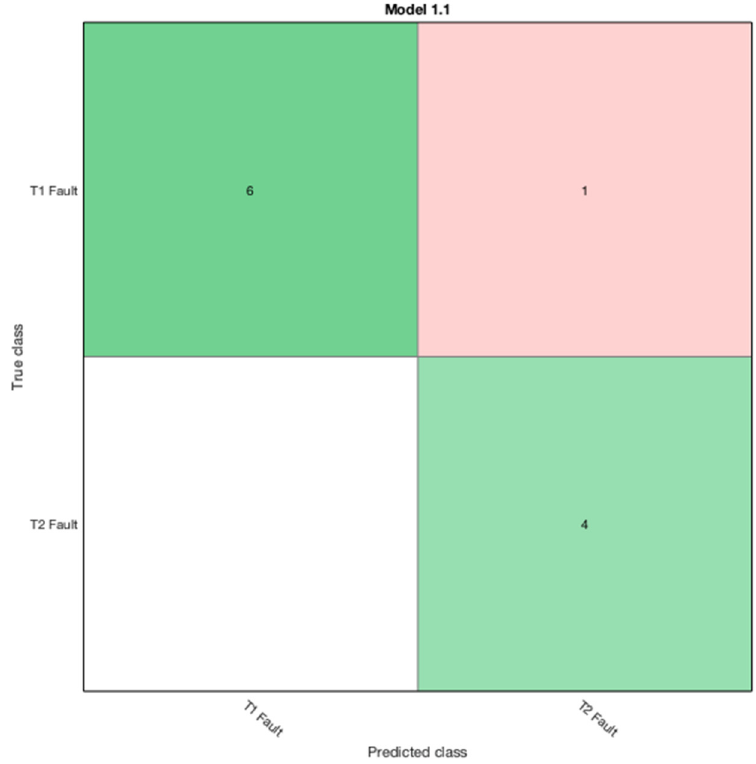
Figure 16. Confusion matrix for SVM 4.